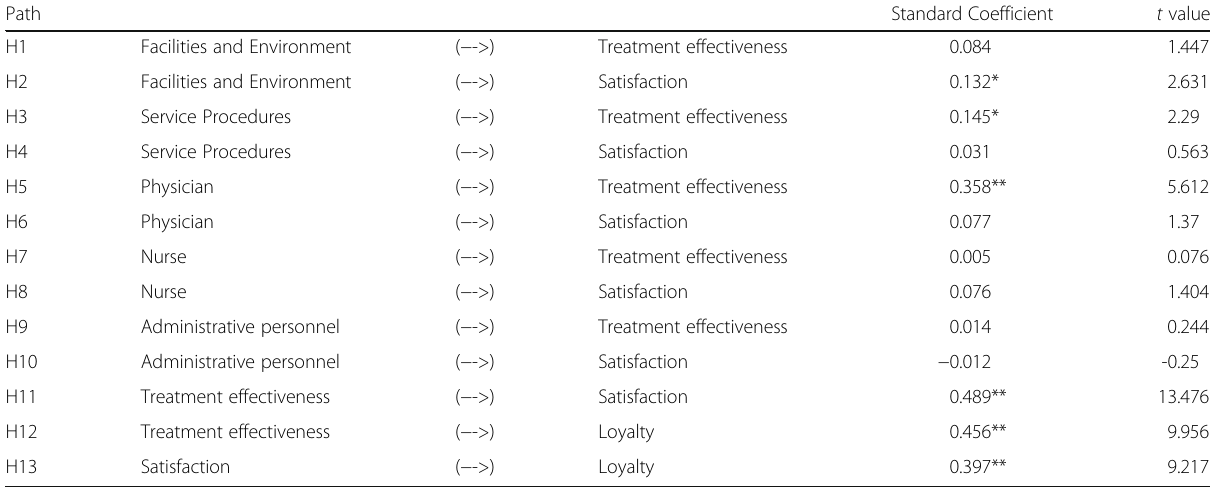
Table 4 Path coefficient results in structural equation modeling Path